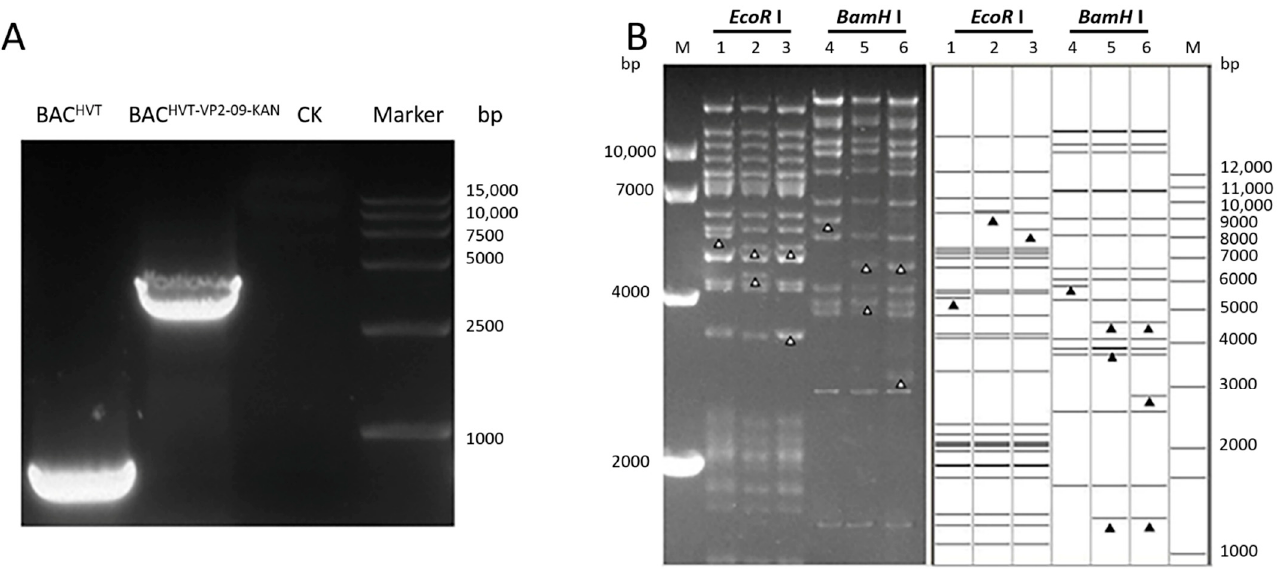
Figure 3. PCR and RFLP of BAC HVT-G, BAC HVT-VP2-09-KAN , and BAC HVT-VP2-09 : ( A ): PCR analysis was performed on the DNA of BAC -HVT and BAC -HVT-VP2-09 in the presence of the VP2 expression cassette with primers (HVT UL55 Flanking F/R). ( B ): DNA of BAC HVT-G BAC clone Sa and recombi- nant BAC HVT-VP2-09-KAN and BAC HVT-VP2-09 was prepared by mini-prep and digested with Bam H I and Eco R I, respectively. Separation of digests was performed by 0.8% agarose gel electrophoresis for 16 h under 40 V. BAC HVT-G is labeled Line 1 and Line 4, which digested with Eco R I or Bam H I. BAC HVT-VP2-09-KAN is labeled Line 2 and Line 5, which digested with Eco R I or Bam H I. BAC HVT-VP2-09 is labeled Line 3 and Line 6 which digested with Eco R I or Bam H I. The arrowhead (lane 1) shows a band, while the two arrows (lane 2) show two new bands when digested with Eco R I. Meanwhile, the arrow (lane 3) shows a new band and the same arrow as Lane 2 when digested with Eco R I. Lanes 4–6 are the Bam H I digestion patterns of BAC HVT-G and BAC HVT-VP2-09-KAN and BAC HVT-VP2-09 , respectively. Their results are the same as expected. The prediction of digestion was performed using the HVT whole genome sequences as a reference (GenBank ID: AF291866). Predicted RFLP patterns of BAC HVT-VP2-09-KAN and BAC HVT-VP2-09 compared to the BAC HVT-G clone with size markers from 1 to 12 kb on the right. M: DL 10,000 DNA Marker (Takara). 3.4. Rescue of the Recombinant HVT BAC Containing the VP2 Expression Cassette A mixture of approximately 1 μ g DNA of BAC HVT-VP2-09 (NJ09) and approxi- mately 5 μ g DNA of a PCR fragment was amplified with DNA of HVT Fc-126 as a tem- plate and with a pair of primers (HVT INS’ gC F/R) was transfected into CEF cells. Non- fluorescent plaques were observed under UV light (488 nm) at 3–4 days post-seeding of the transfection cell culture (Figure 4A). A homogeneous population of purified viruses, termed HVT-VP2-09 (NJ09), was isolated after several rounds of picking and plating. PCR of gC with primers (HVT gC Flanking F/R) and VP2 expression cassette with primers (HVT UL55 Flanking F/R) showed bands of 2059 bp and 3757 bp, respectively, as